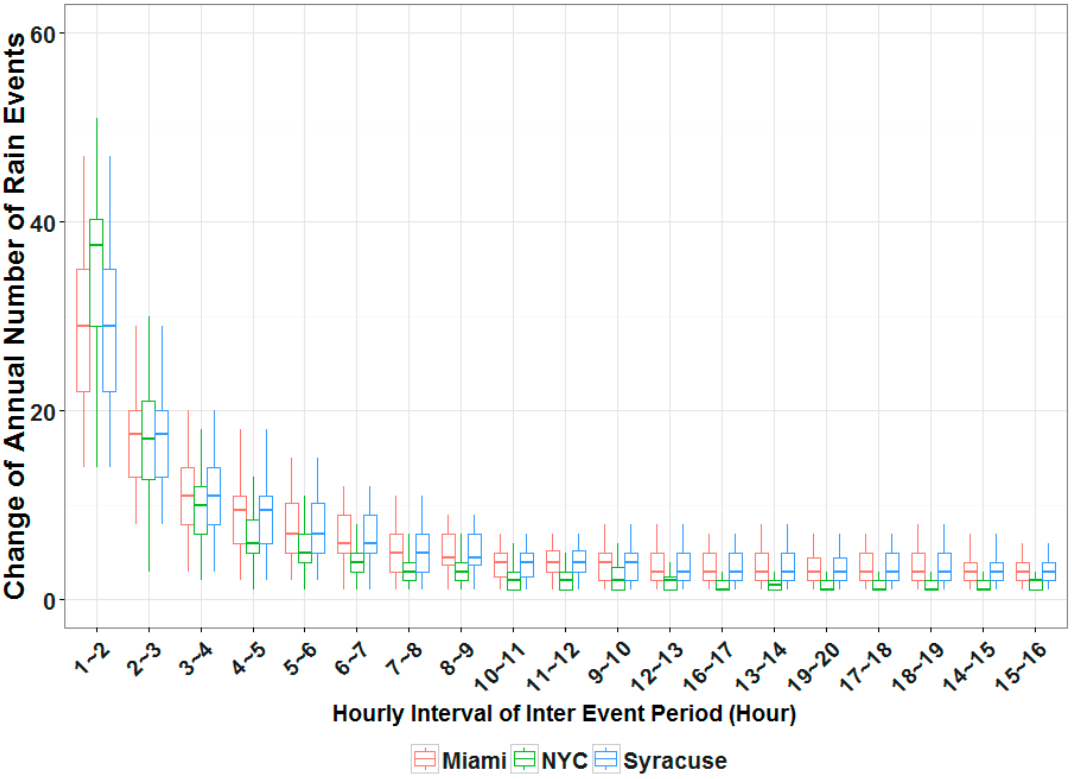
Figure 1. IntEDP analysis for Miami, NYC, and Syracuse.